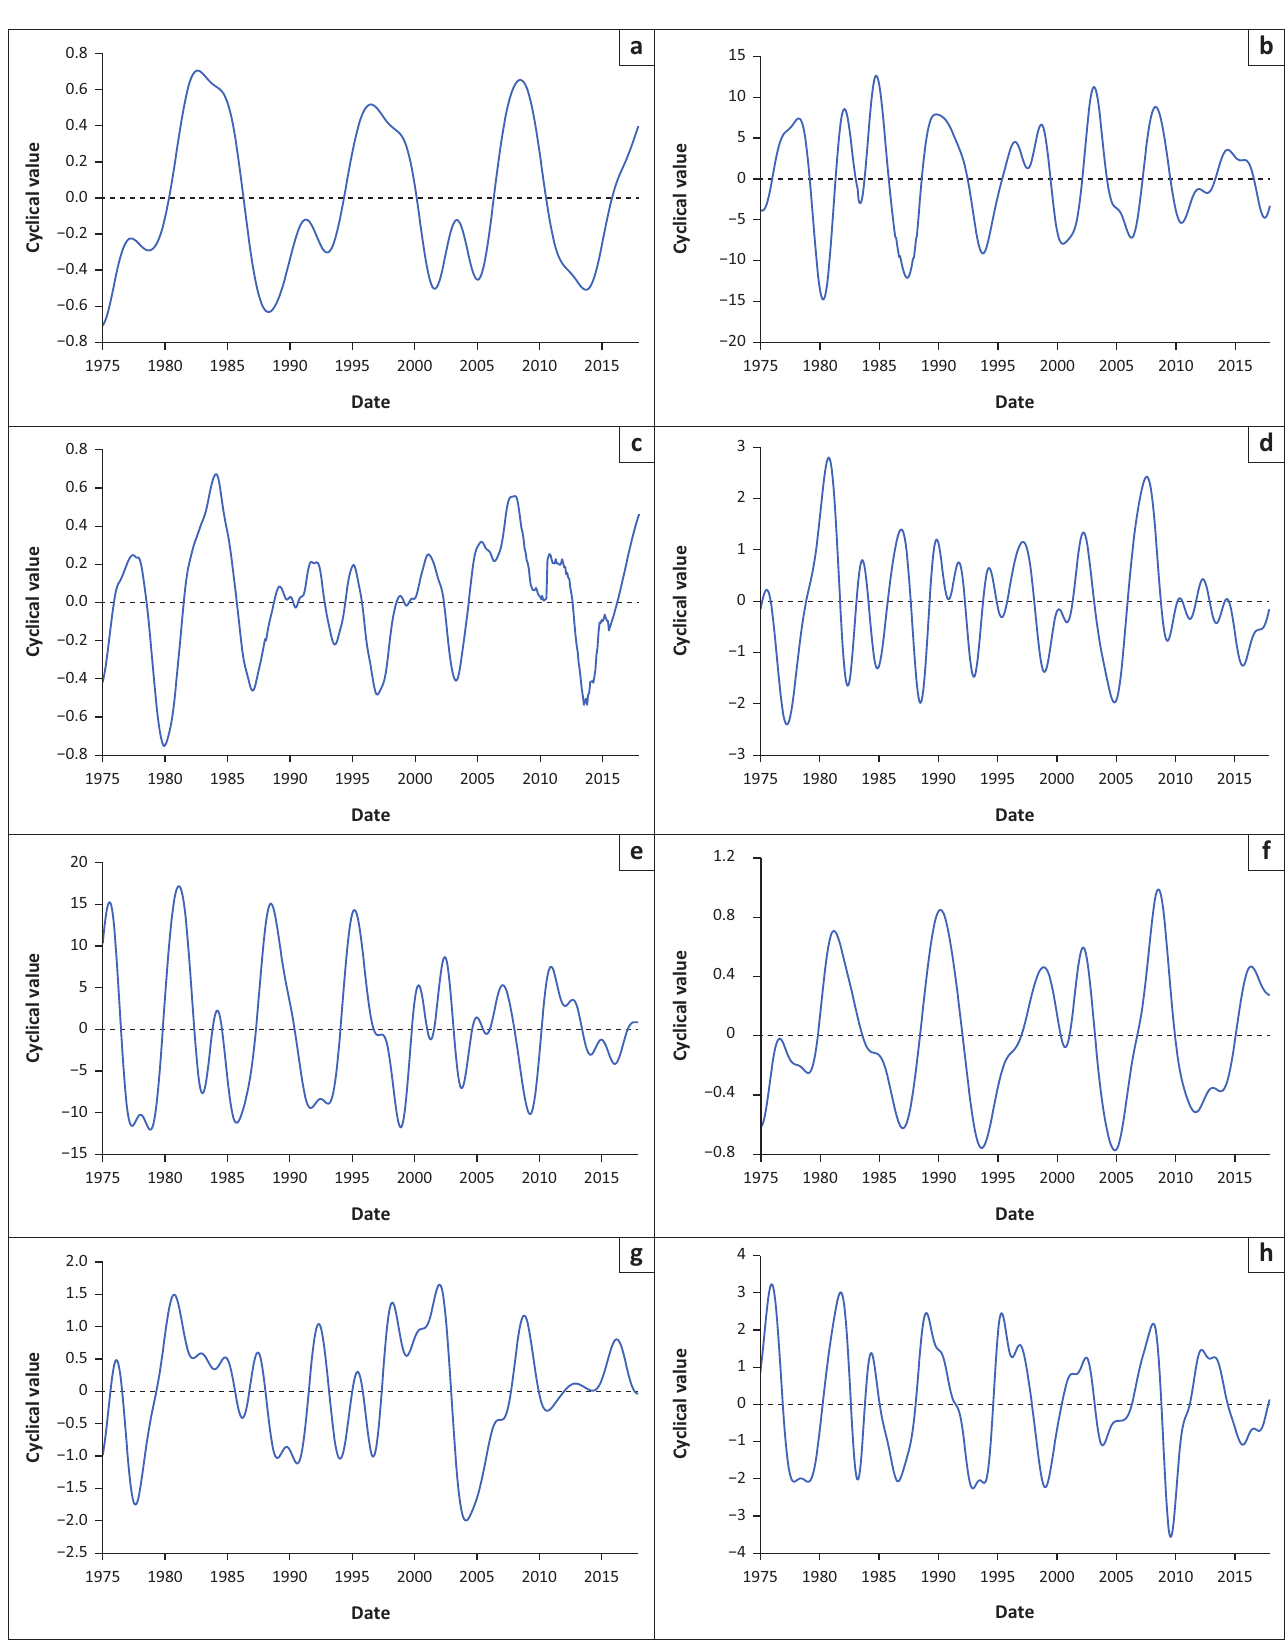
FIGURE 3: Cyclical extractions for each South African financial section. (a) credit cycle, (b) interest rate cycle, (c) house price cycle, (d) equity cycle, (e) confidence cycle, (f) balance sheet cycle, (g) foreign financial position cycle, (h) business